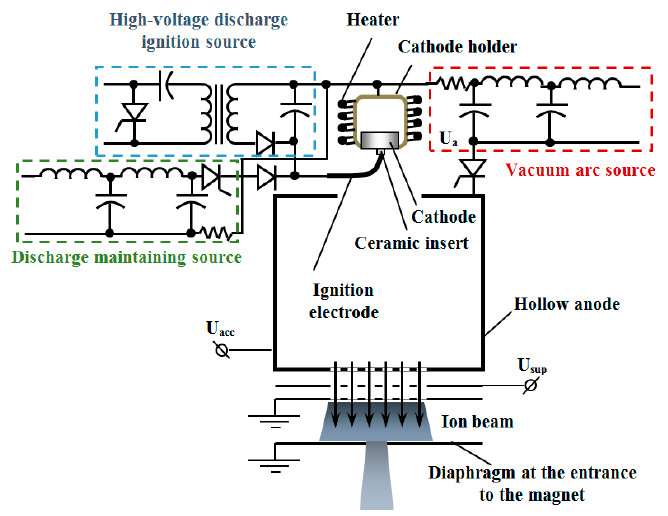
Figure 5. Schematic diagram of a boron ion source based on a vacuum arc discharge [49].